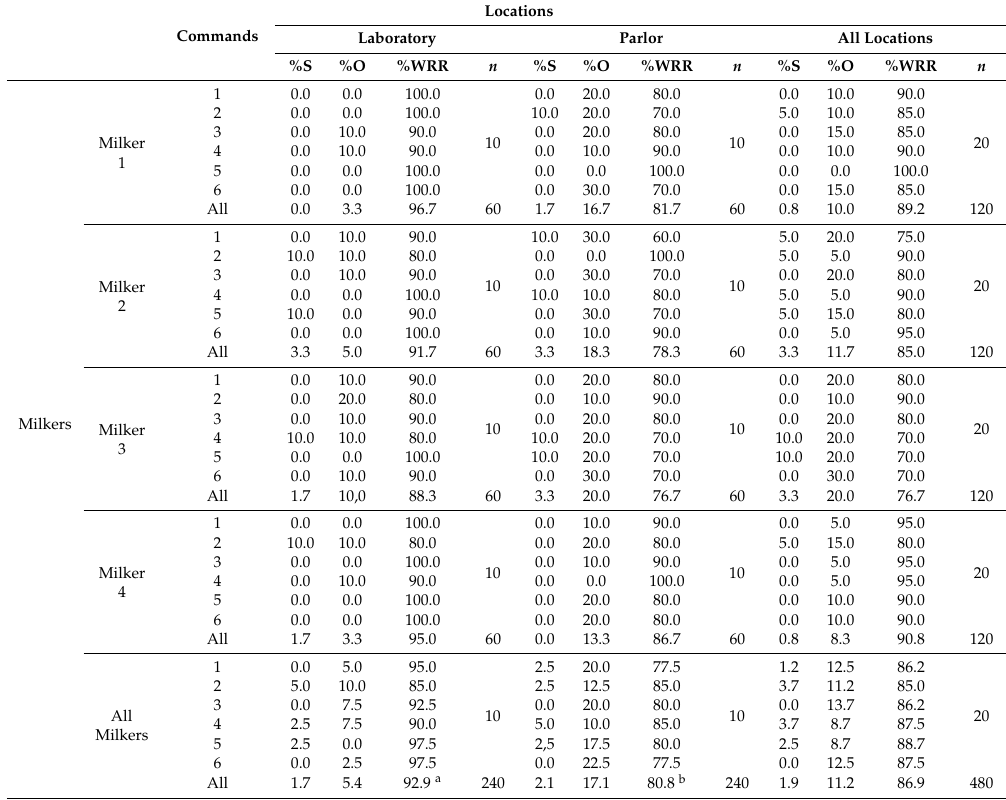
Table 1. Results obtained in the tests reported in terms of %WRR (word recognition rate). Locations Commands Laboratory